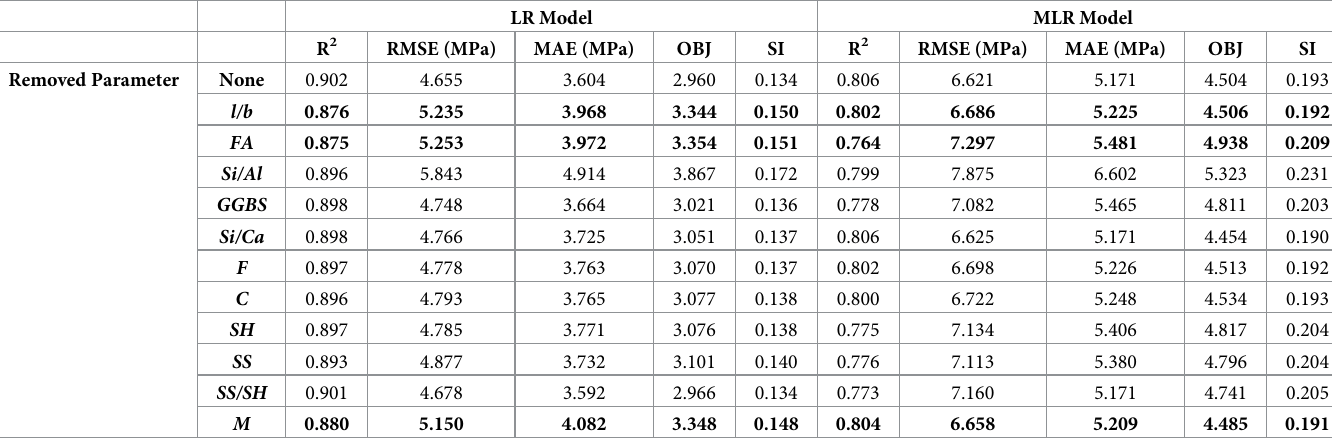
Table 3. Sensitivity analysis using LR and MLR